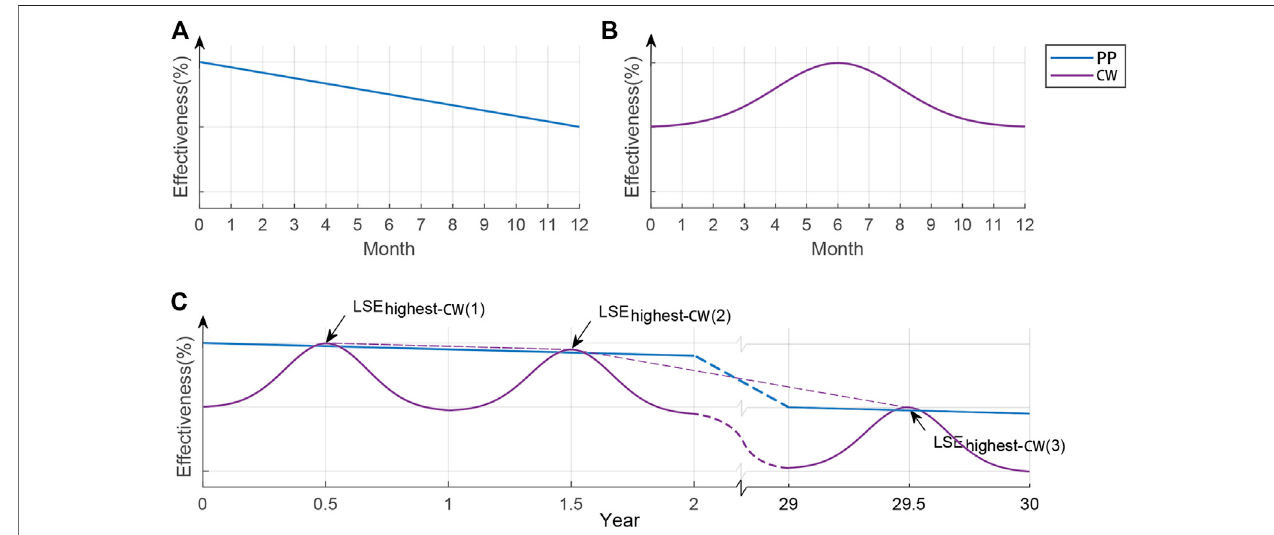
FIGURE 2 | (A) Potential mean PP effectiveness during each year, (B) potential mean CW effectiveness during each year, and (C) example of composite mean PP and CW effectiveness over the design life span.